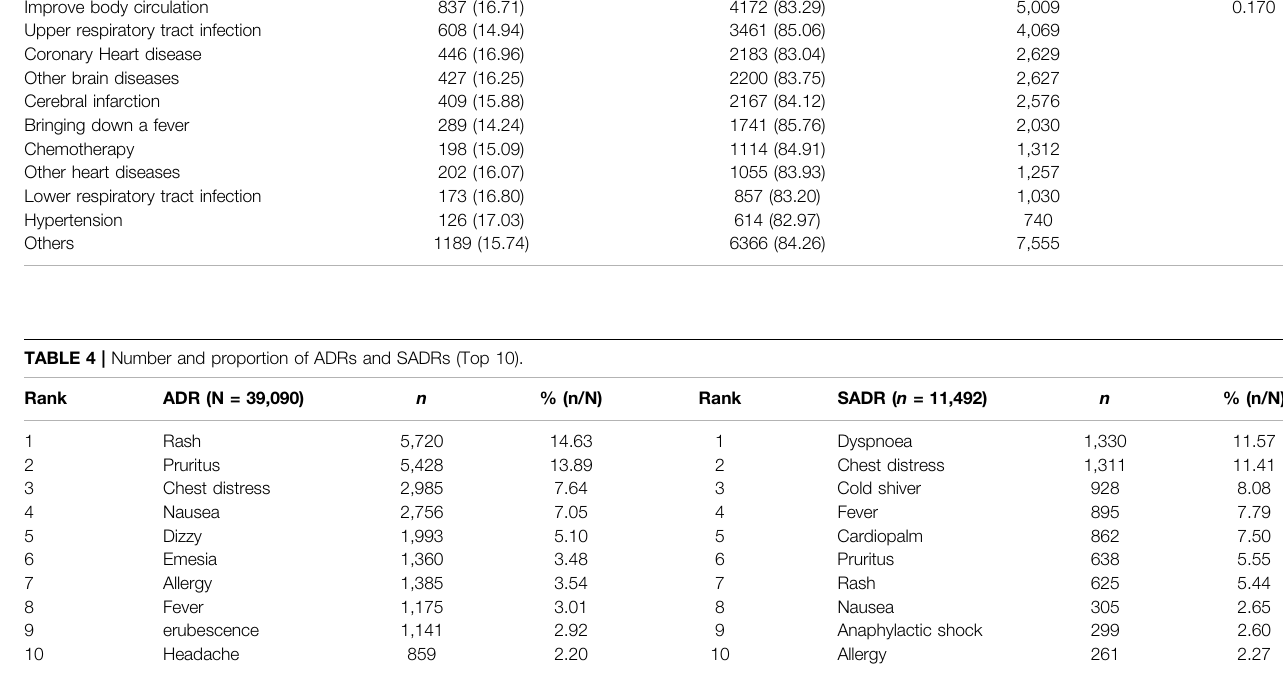
TABLE 5 | Severity level of TCM injections by demographic variables and medications.